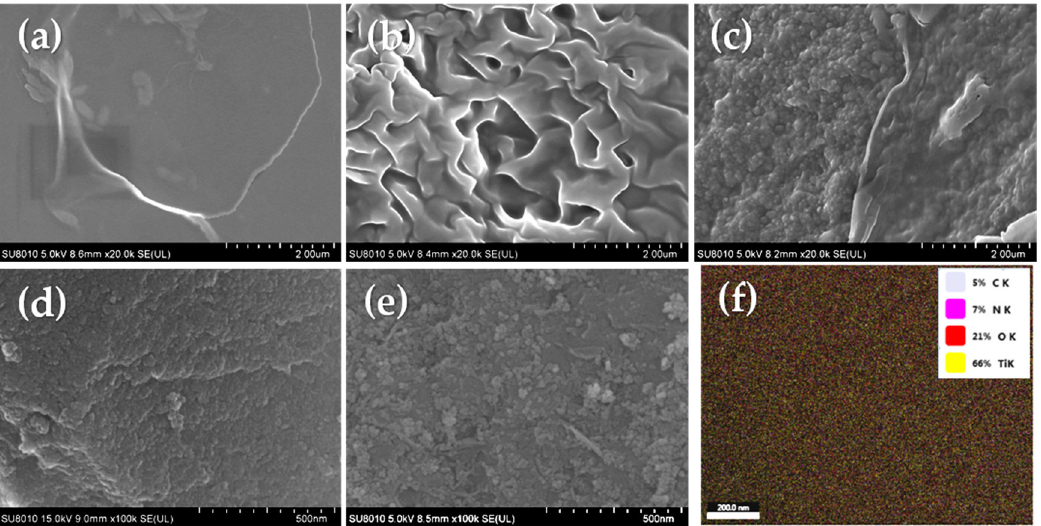
Figure 1. Top-surface SEM images of the ( a ) GO, ( b ) NGR nanosheets, ( c ) NGRT nanosheets, ( d ) AC nanoparticles, and ( e ) NGRT@AC nanocomposite.